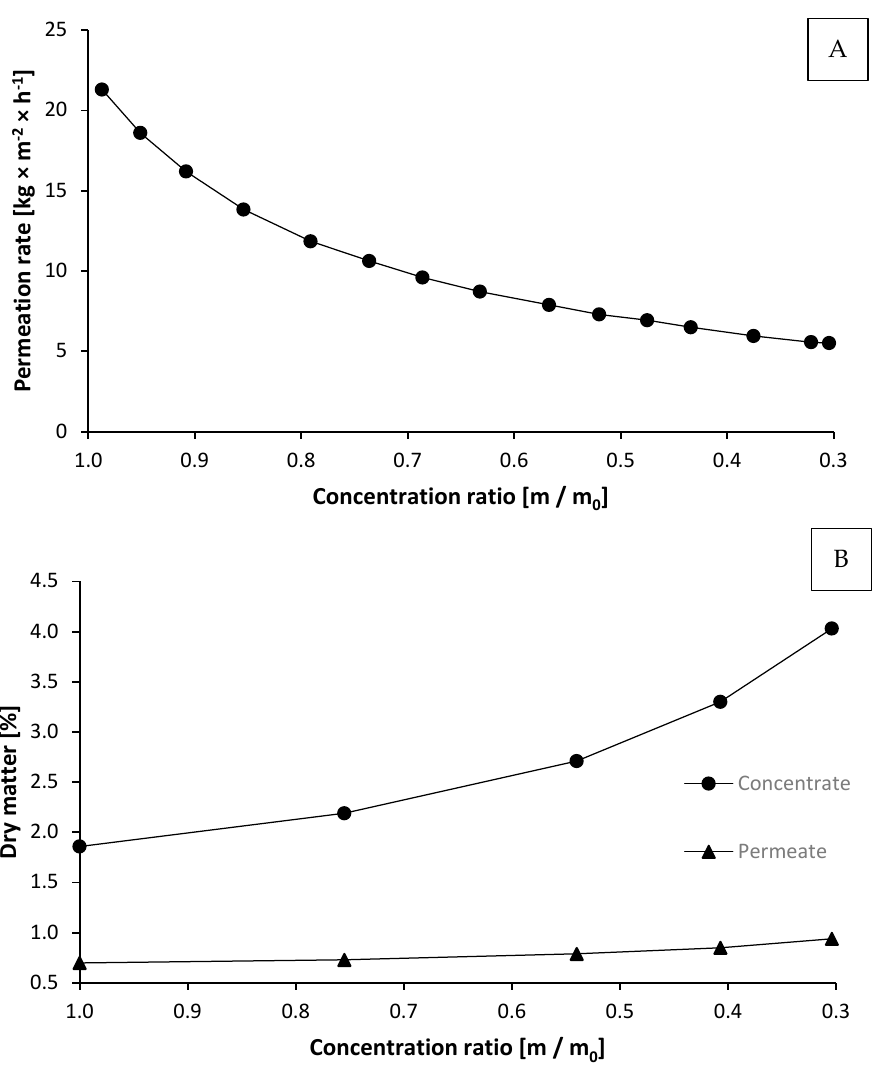
Figure 2. Development of the permeation rate ( A ) and dry matter ( B ) of concentrate and permeate as a function of the concentration ratio during ultrafiltration. Thereby, m is the current mass of the concentrate during filtration and m0 the mass of the concentrate at the beginning of the process (31.99 kg).